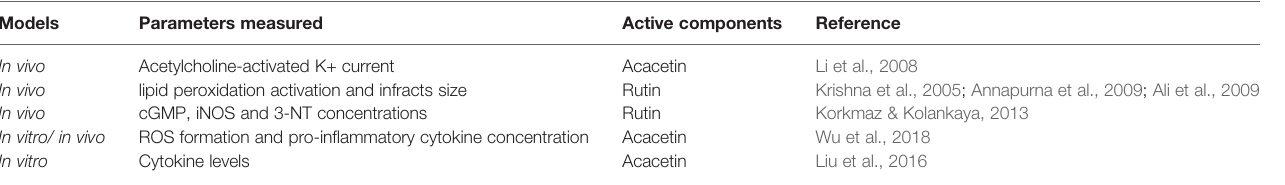
TABLE 2 | Summary of ischemia/reperfusion injury protection of “ Snow lotus ” and/or its major biochemical.